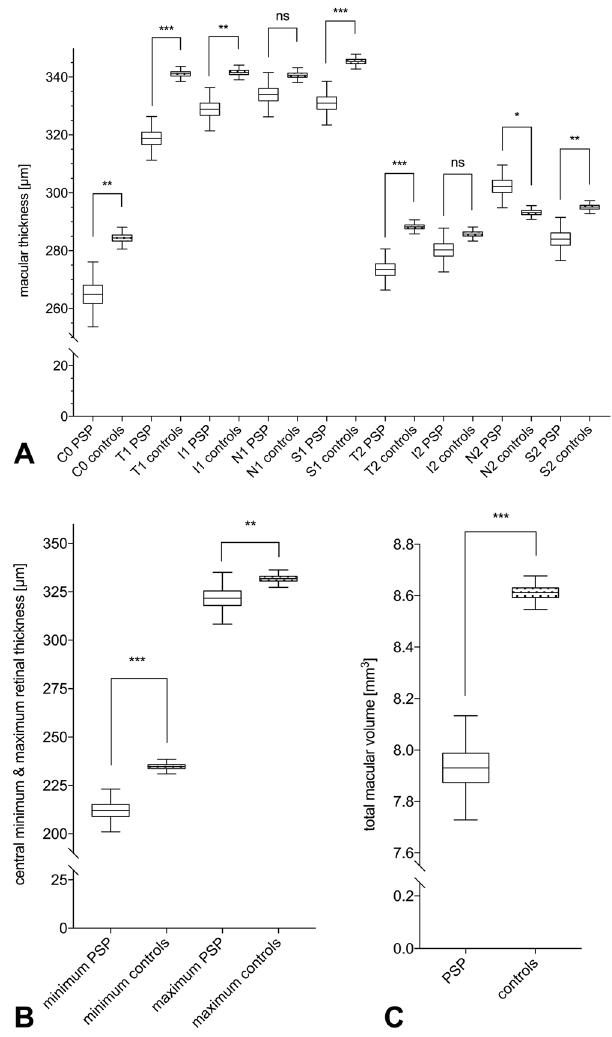
Figure 2. Macular data measured by OCT. ( A ) Macular thickness in all eight sectors of PSP patients and controls are shown. ( B ) Central minimum and maximum retinal thickness within the macular area are pictured. ( C ) The total macular volume in mm 3 of PSP patients and controls is shown. ns: not significant p > 0.5, * p ≤ 0.5, ** p ≤ 0.01, *** p ≤